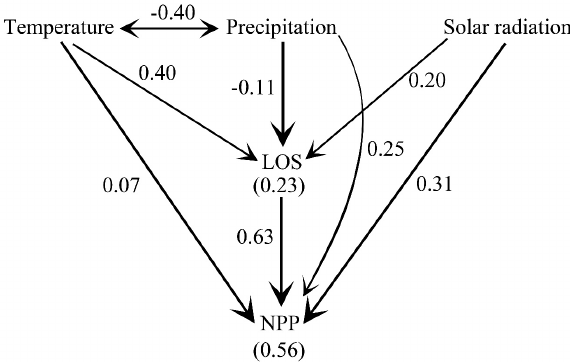
Figure 8. Structural equation model relating climatic factors, Length of Season (LOS) and Net Primary Productivity (NPP) in China. Single headed arrows indicate directional relationships, while double headed arrows indicate covariances. Numbers in brackets are R 2 values.